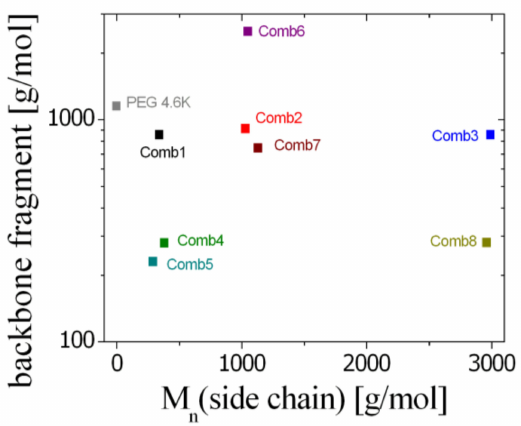
Figure 1. The molar masses of the backbone fragment (i.e., the average molar mass connecting two side chains, M BBtot / N SC ) and the side chain for all comb polymers. A wide variety of parameters